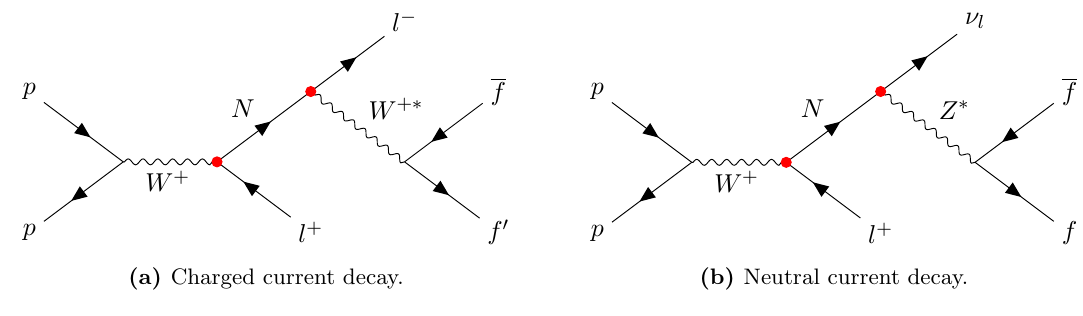
Figure 3. Feynman diagrams for the processes pp ! l (cid:6) charged and neutral current in panel (a) and (b),